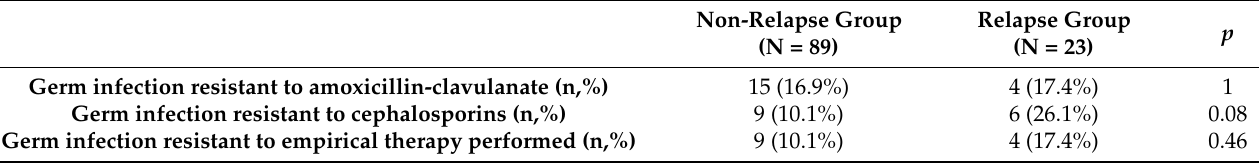
Table 3. Comparison of first urinary tract infection characteristics in the two groups.